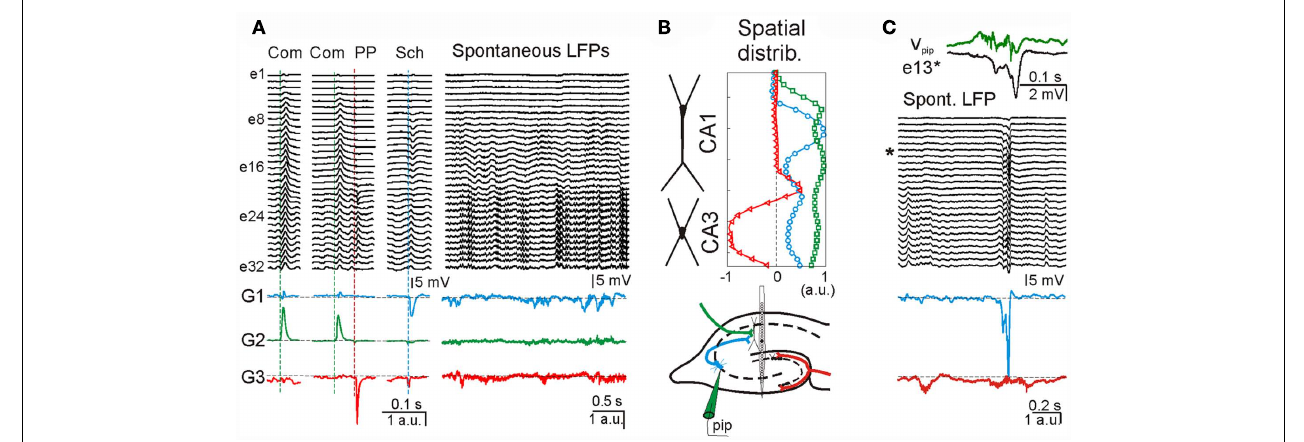
afferent axons colored in the scheme of the hippocampal connections (bottom subplot). (C) Matching pre- and post-synaptic activity for one generator.The activity of the CA3 region was locally manipulated by pharmacological disinhibition applied through a pipette (pip, in B,